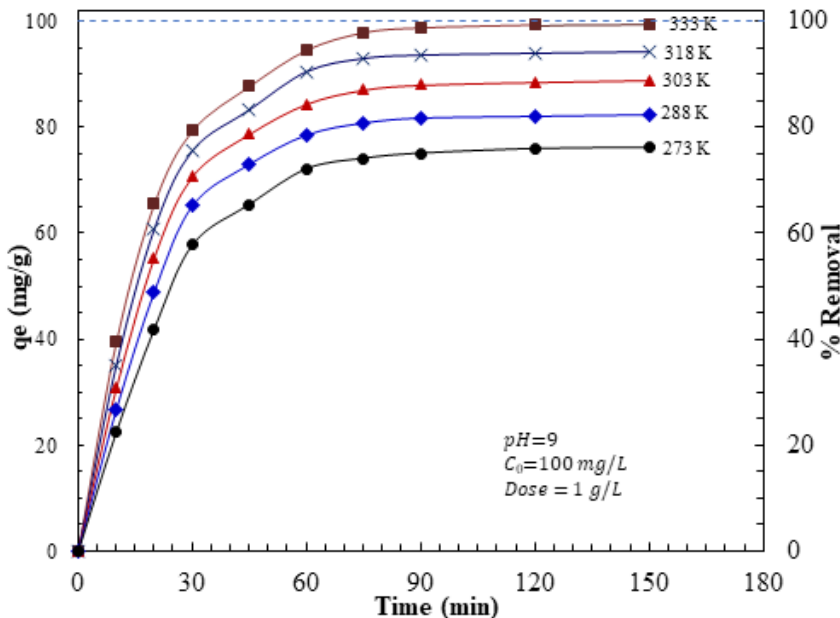
Figure 2. Influence of contact time and temperatures on the adsorption capacity and removal efficiency of AZM by AFAC.